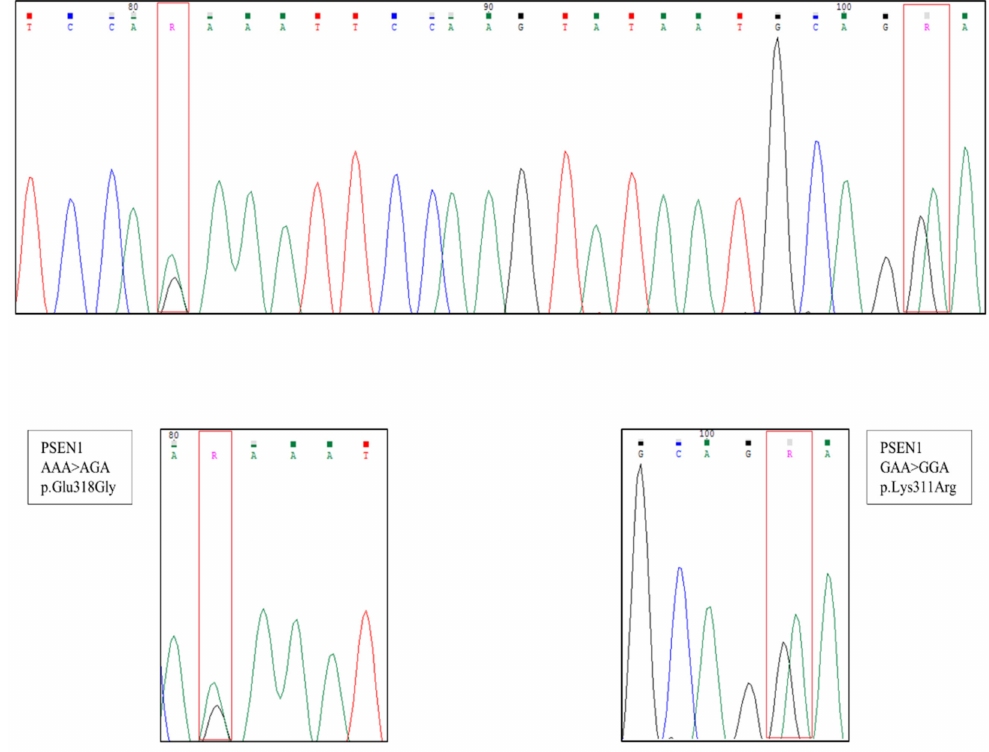
Figure 1. Result from the genomic DNA sequencing revealing a double mutation in